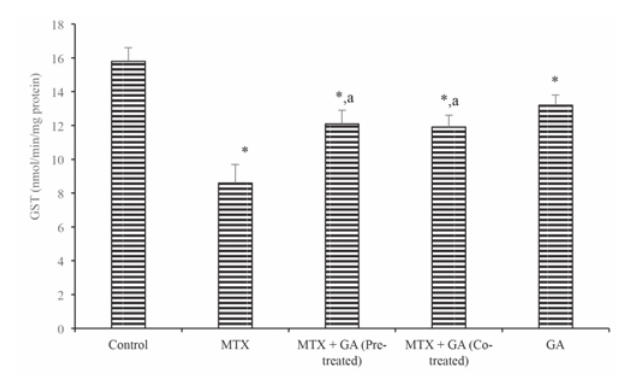
Figure 3. Ameliorative effect of gallic acid pre-treatment and co- treatment on methotrexate-induced reduction in hepatic vitamin C level in rats. Data are expressed as mean ± S.D for six rats in each group. *Significantly different from the control (P<0.05); a significantly different from the methotrexate group (P<0.05).